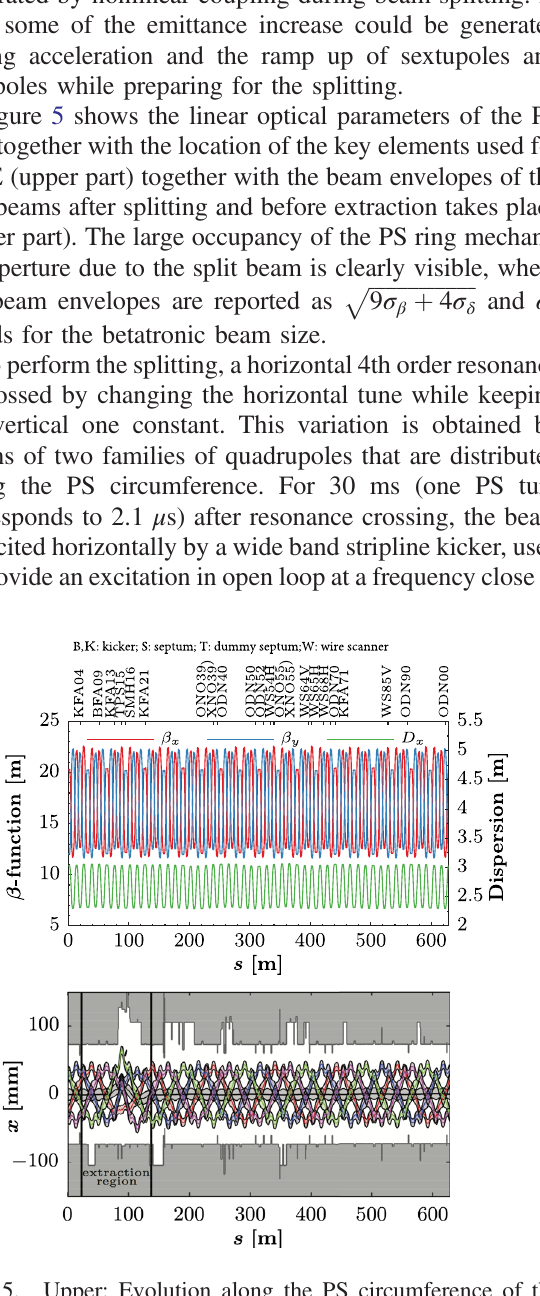
FIG. 5. Upper: Evolution along the PS circumference of the lattice functions, showing also the location of the essential elements for MTE. Bottom: Horizontal ring aperture together with beamlets and core envelope just prior to the pulsing of the kickers. The extraction region indicates the section of the ring where orbit bumps are present. The element name includes the number of the straight section in which the device is